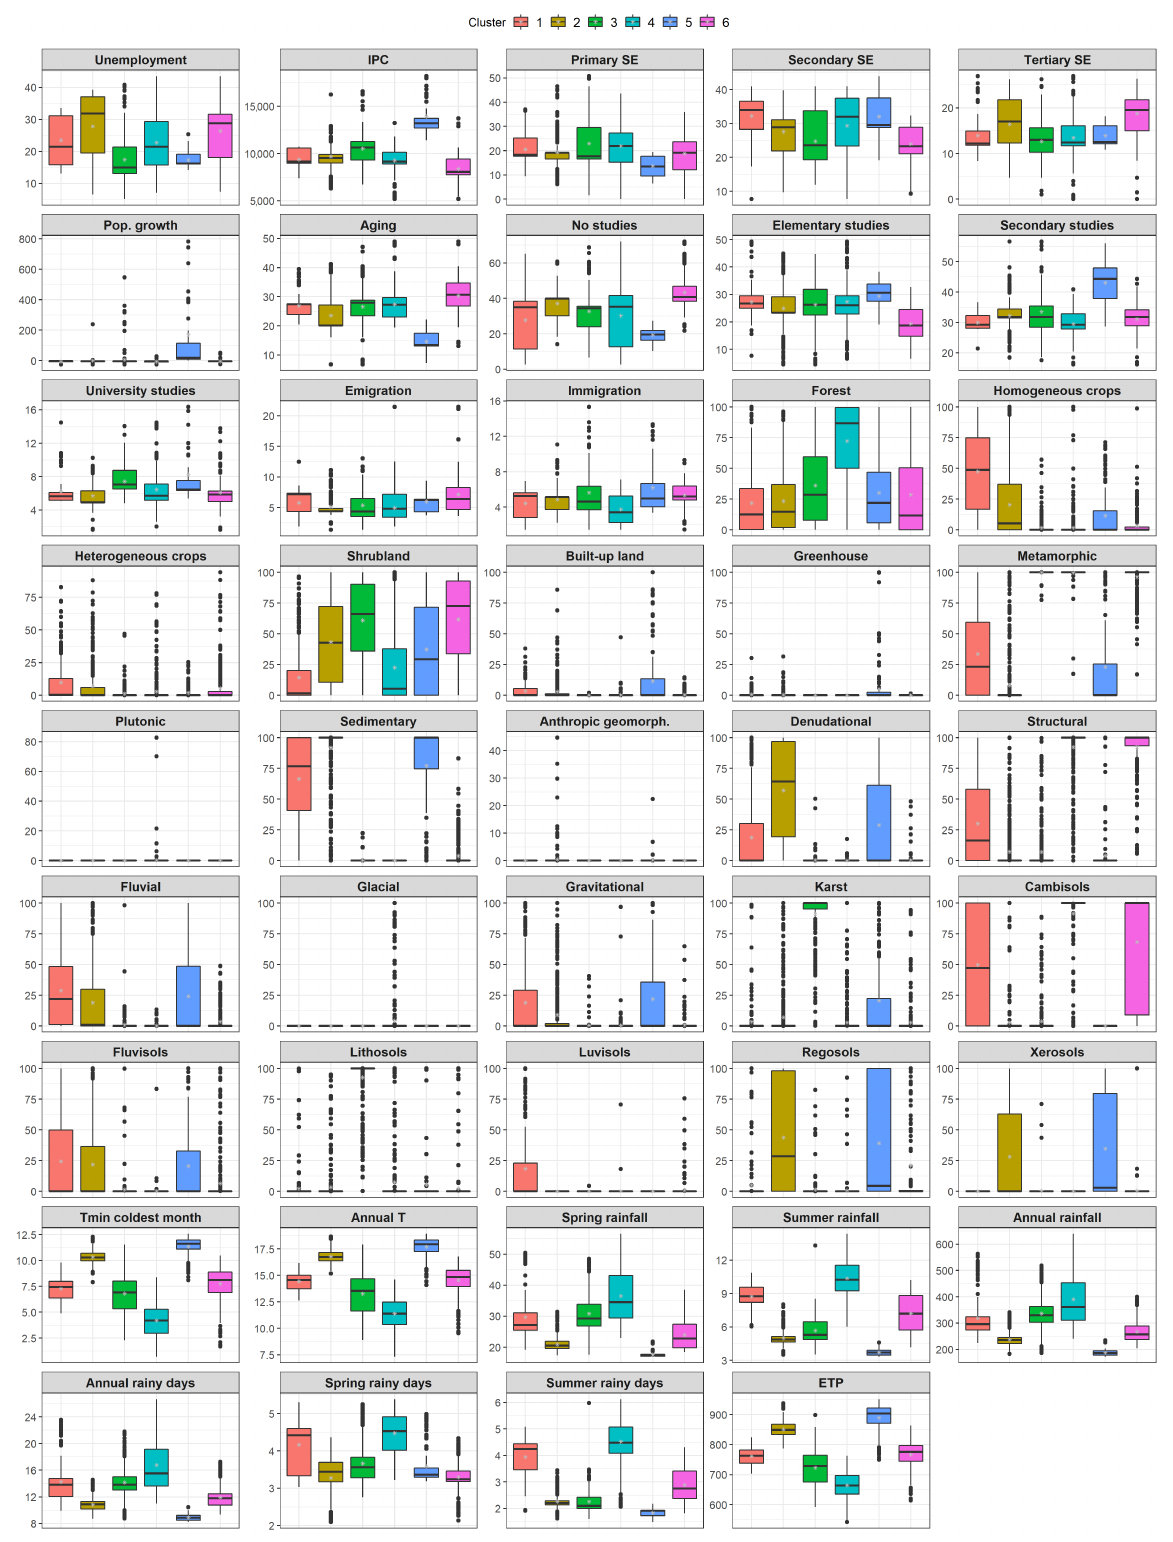
Figure A1. Boxplots of the socio-ecological variables per socio-ecological sector. IPC, Income Per Capita; Pop. growth, population growth; geomorph., geomorphology; ETP, evapotranspiration rate; T, temperature; Tmin, minimum